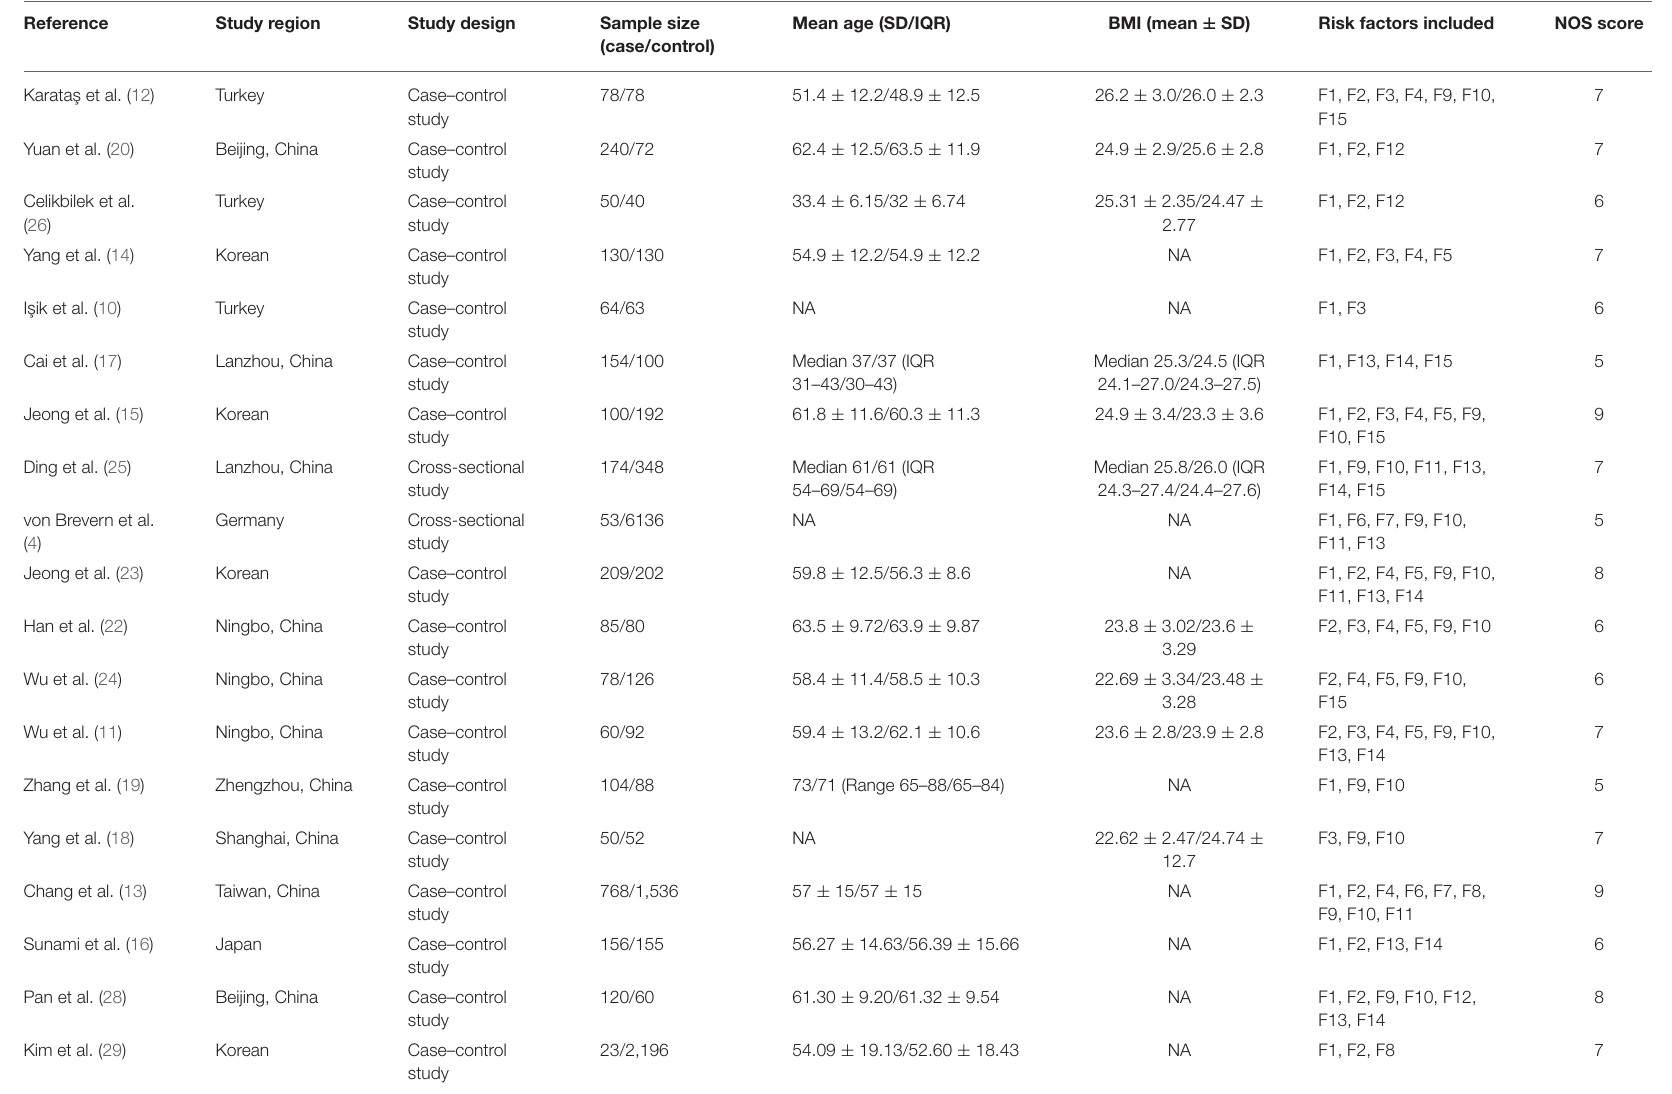
TABLE 1 | Baseline characteristics of each study included in this